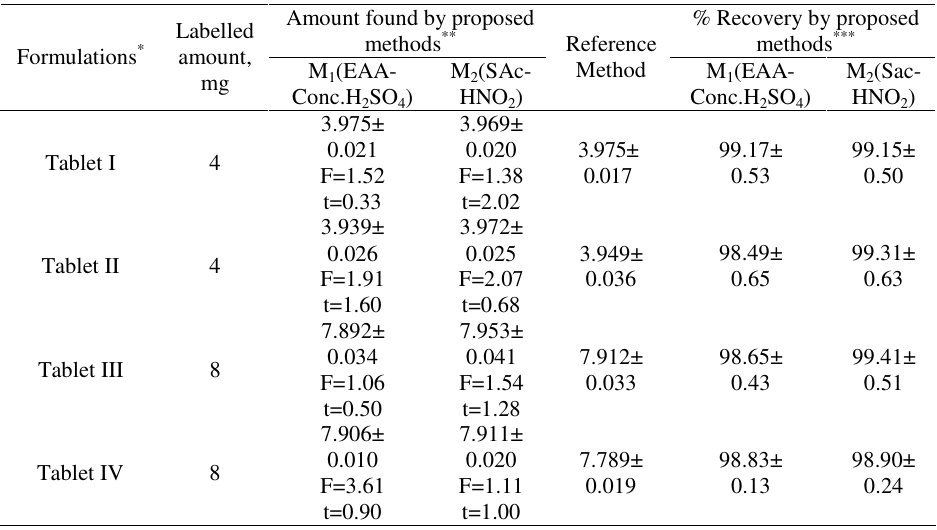
Table 2. Assay of REB in pharmaceutical